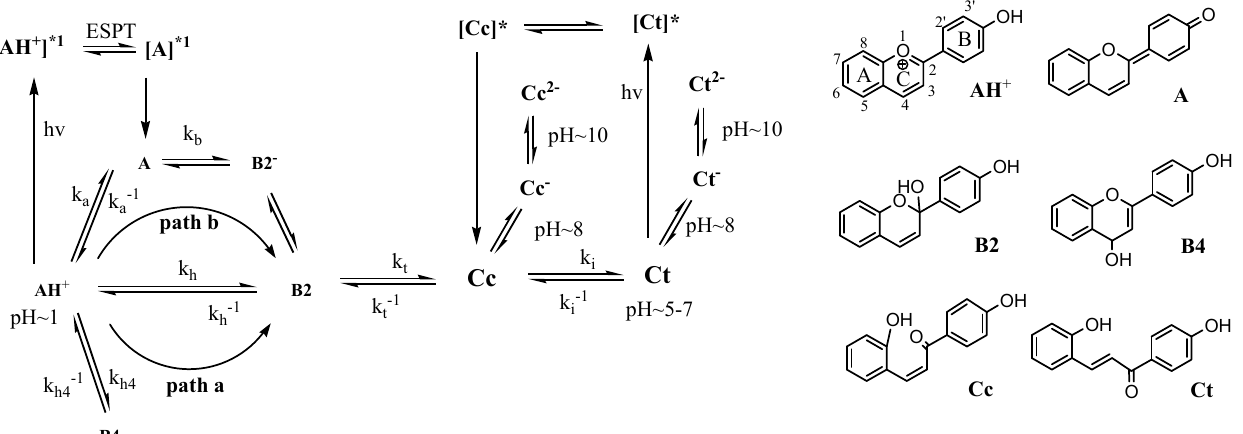
Figure 1. Thermal mechanism of flavylium ion with CB using F1 and photochemical mechanism of AH + and Ct as an example. Path a represents the reaction mechanism in an acidic solution, while path b represents the basic mechanism between AH + and B2 .